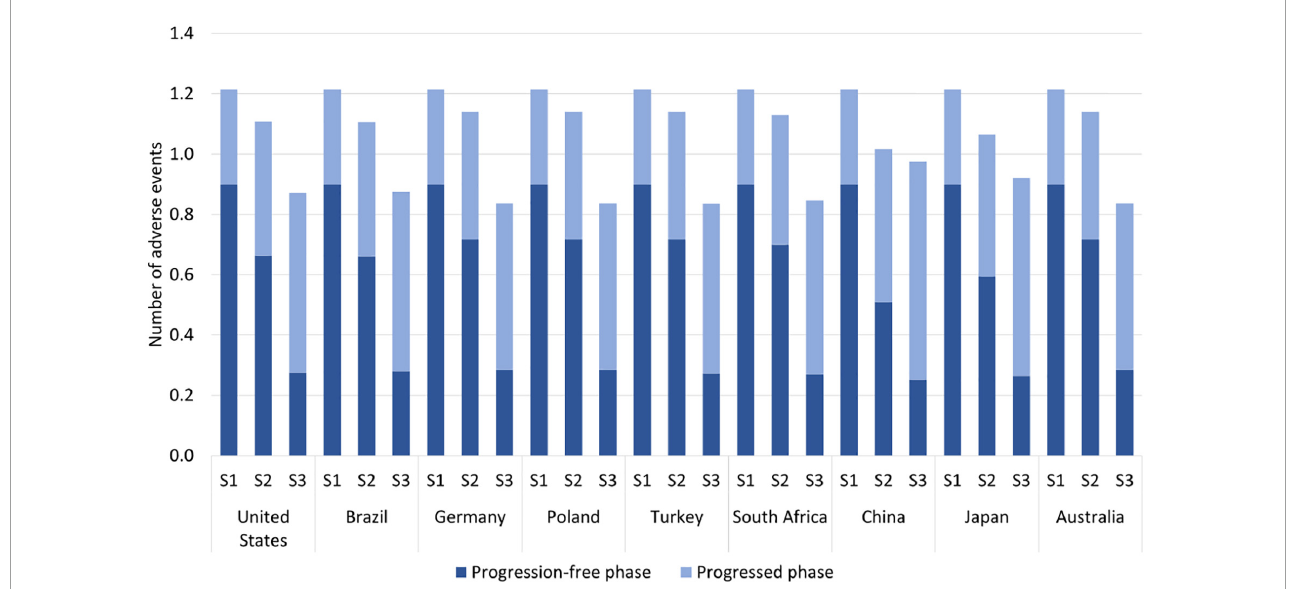
FIGURE3 Estimated number of adverse events per patient by testing scenario over a 5-year horizon. S1 = no testing, S2 = sequential testing, S3 = multigene testing. The following eight adverse events (AEs) were included; anemia, neutropenia, fatigue, nausea, vomiting, diarrhea, aspartate amino transferase (ASAT) increase, alanine amino transferase (ALAT)